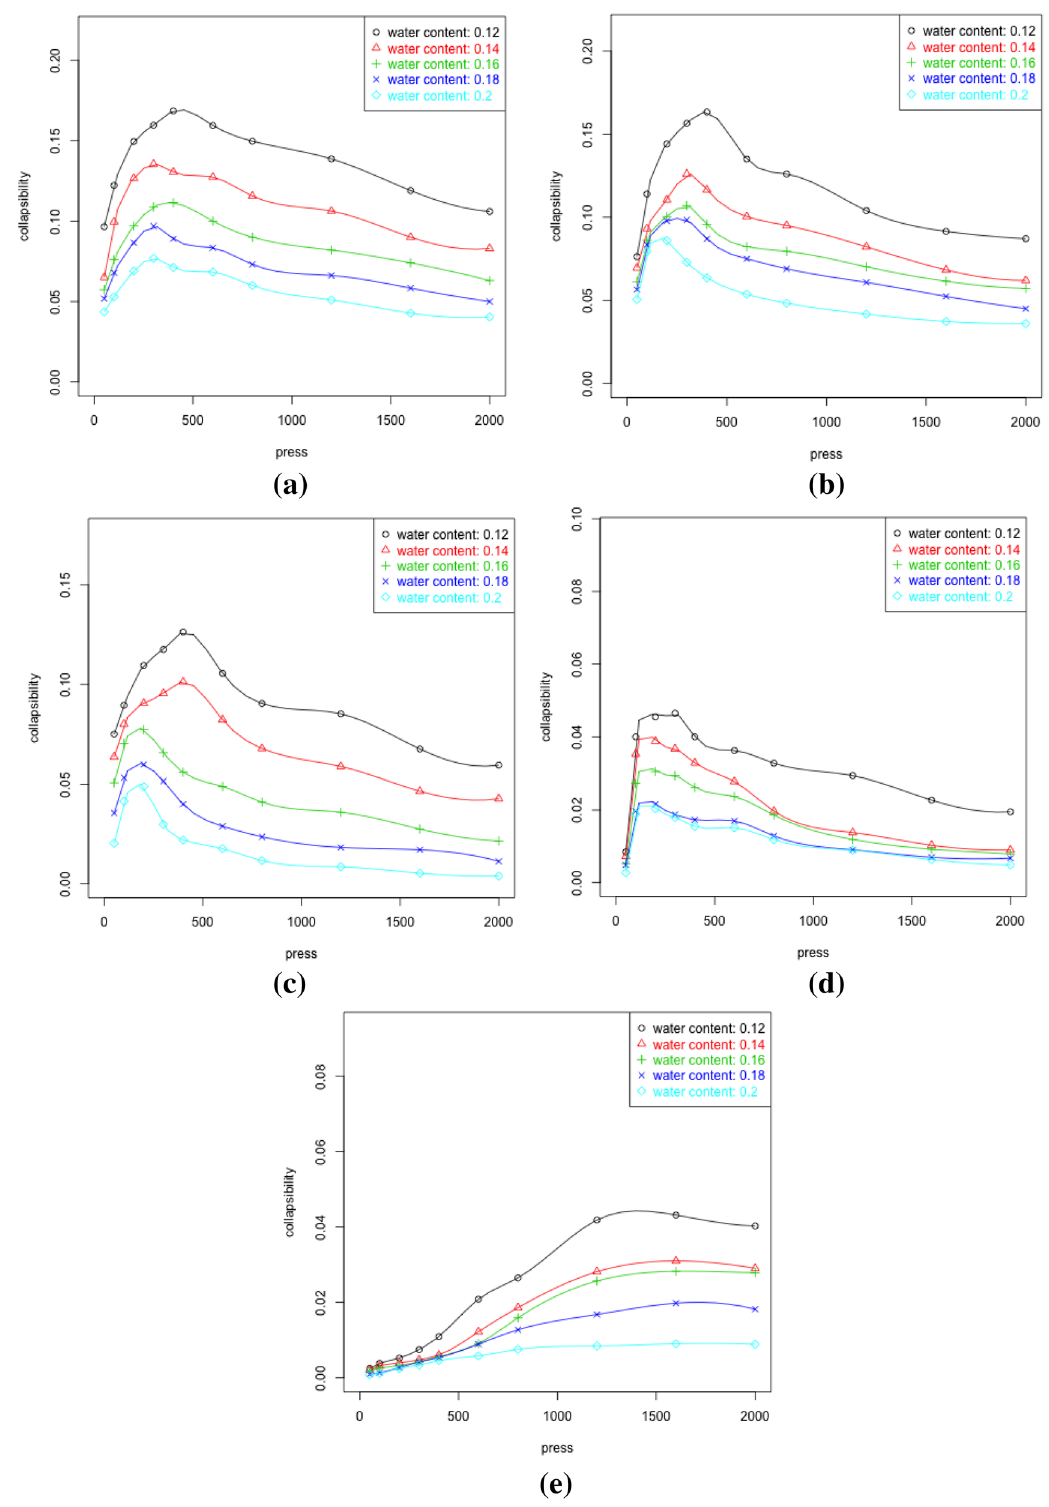
Figure 16. Variation of collapsibility corresponding to press; ( a ) dry density 1.2, ( b ) dry density 1.3, ( c ) dry density 1.4, ( d ) dry density, 1.5, ( e ) dry